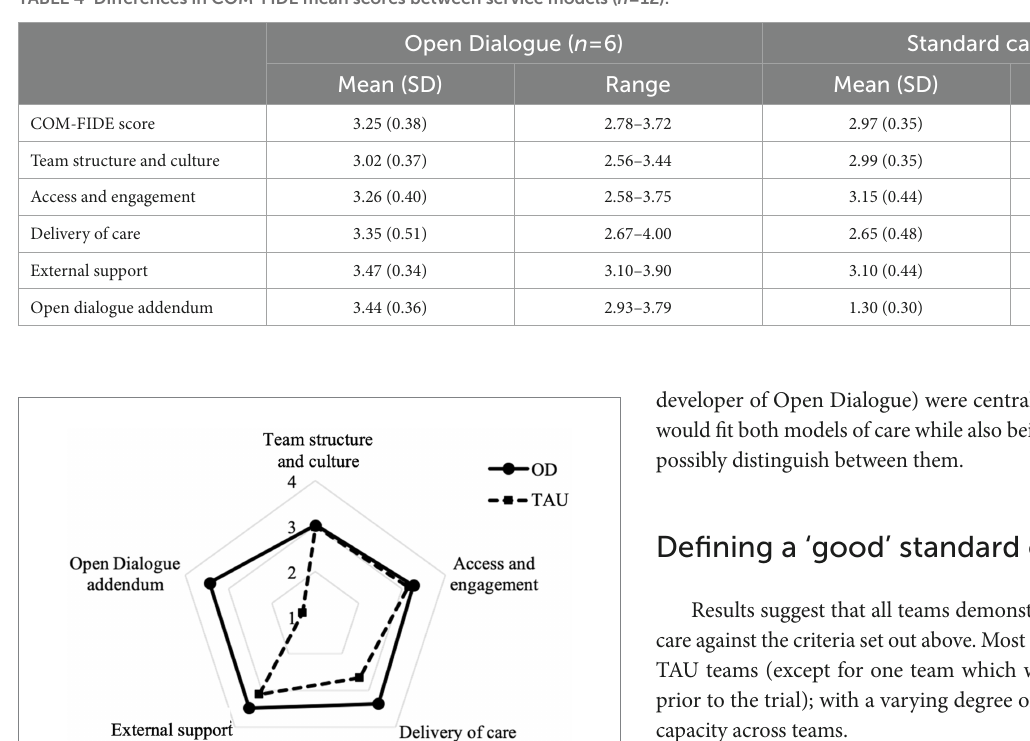
TABLE 4 Differences in COM-FIDE mean scores between service models ( n = 12).